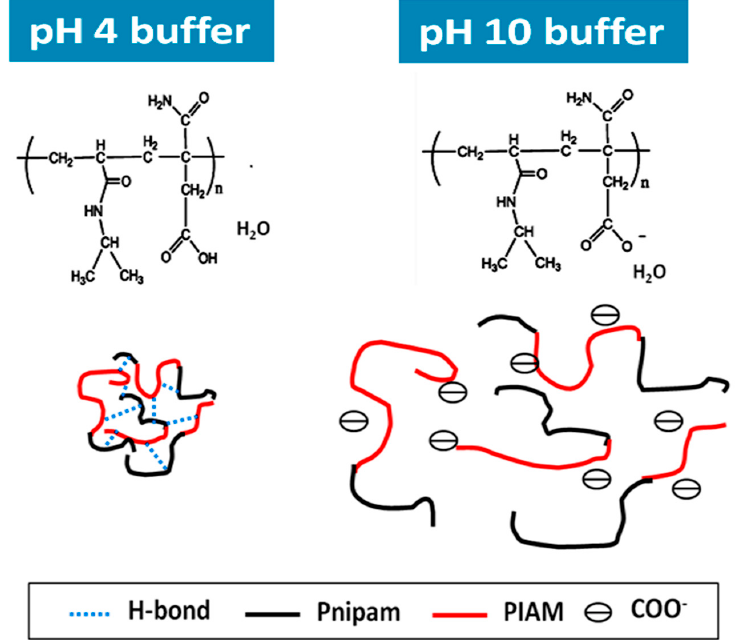
Figure 10. Proposed structures of P(nipam-co-IAM) in the buffer solutions with pH = 4 and 10.